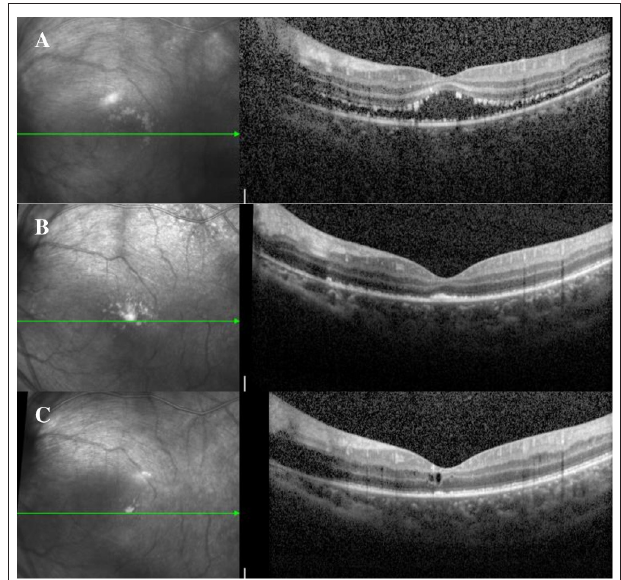
FIGURE 3 | (A) After 3 weeks of antiviral and steroid treatment, the fundus could be gradually observed. OCT revealed macular edema. (B) At the 2-month follow-up, OCT revealed the attached retina after the patient underwent prophylactic laser treatment. (C) At the last follow-up, OCT revealed the retina to be attached; however, cystoid macular edema was still present. OCT, Optical coherence tomography.